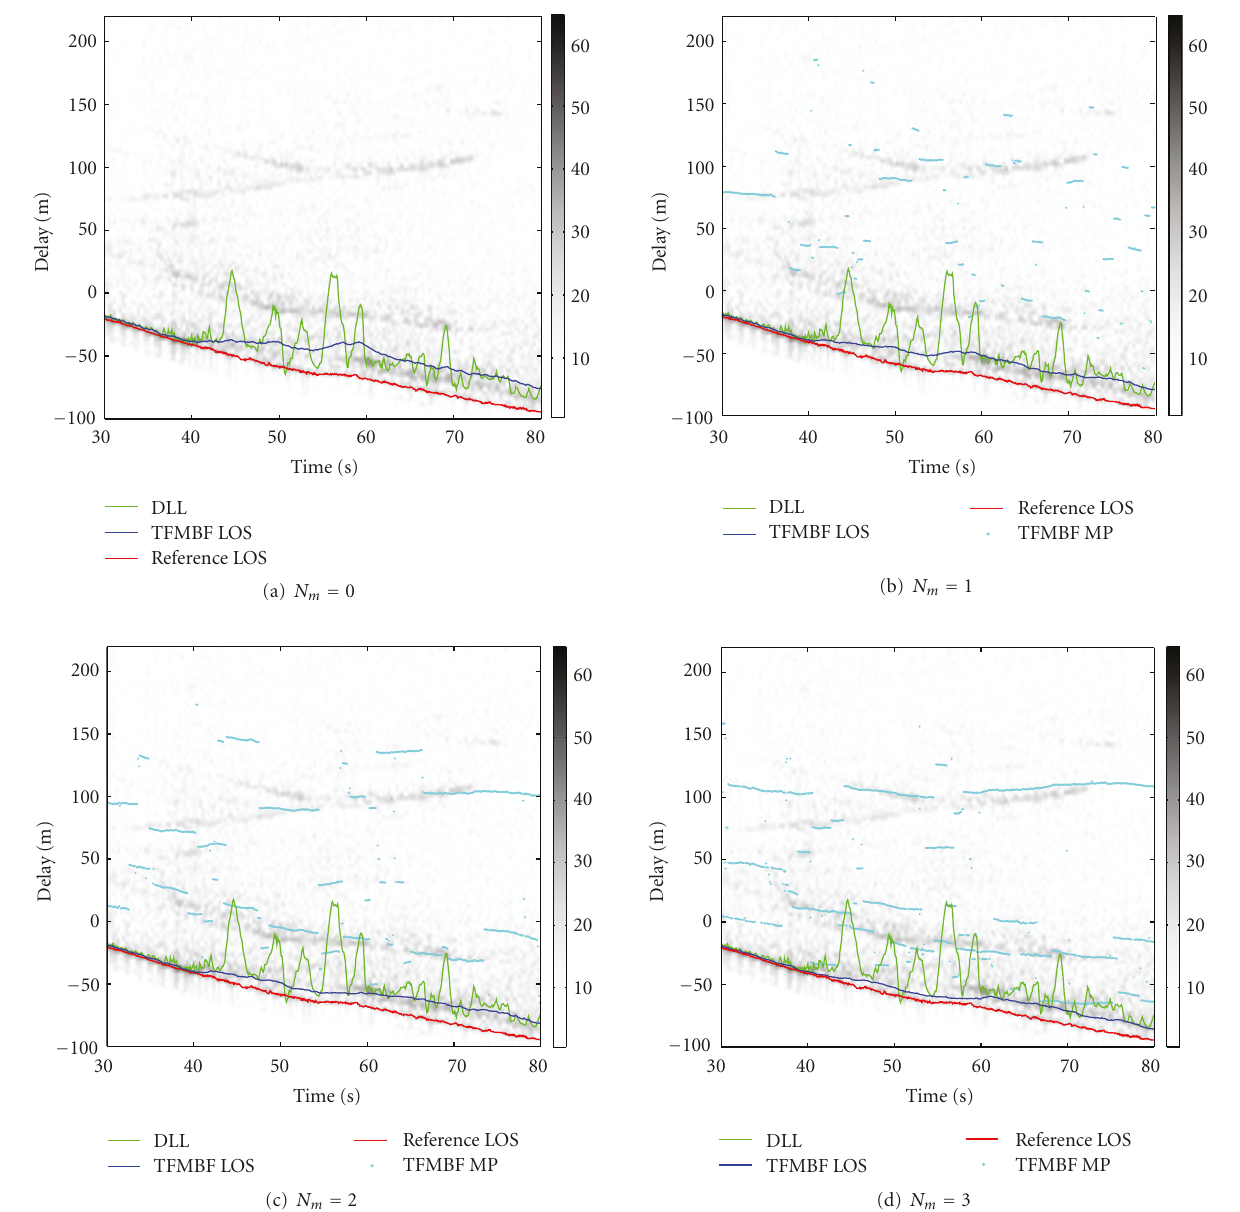
Figure 7: In this scenario, the channel estimation algorithm has to cope with a LOS path (red) that is superimposed by several simultaneous multipath replicas. The DLL receiver (green) shows the typical multipath errors, whose magnitude varies due to the fading processes of the path amplitudes. If the multipath replicas are not taken into account by the estimator ( N m = 0, (a)), the LOS estimate (dark blue) shows still significant errors, but their magnitude is smaller than the DLL errors, since the dynamic model used in the estimator helps to constrain variation of the LOS estimate. With N m = 1 (b) the number of considered paths is too small to track all replicas and thus the multipath delay estimates (light blue) tend to jump between the respective multipath signals. Once the number of considered replicas is su ffi cient to take into account all present signals ( N m > 1, (c, d)), the estimation algorithm detects and tracks the channel, except for the period between 40 s and 80 s. During this interval, a proper resolution of the actual LOS does not seem feasible any more, due to the presence of an echo which is born with almost zero delay w.r.t. the LOS path which itself is strongly attenuated, hence its history does not allow to separate it suitably from the LOS